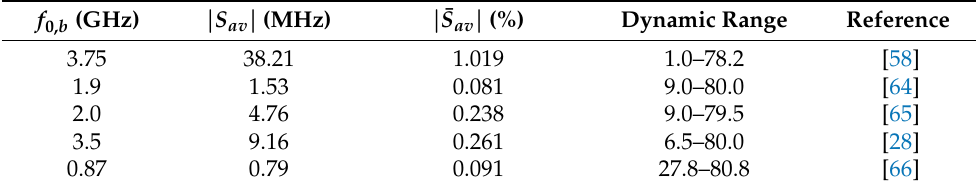
Table 2. Comparison of various frequency-variation sensors in terms of sensitivity. f 0, b